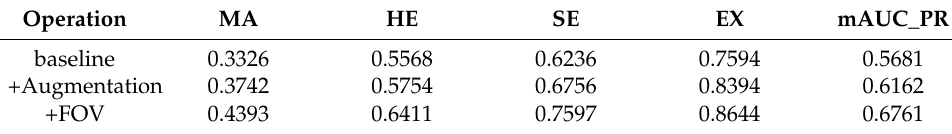
Table 6. Performance comparison of weightage of hybrid loss